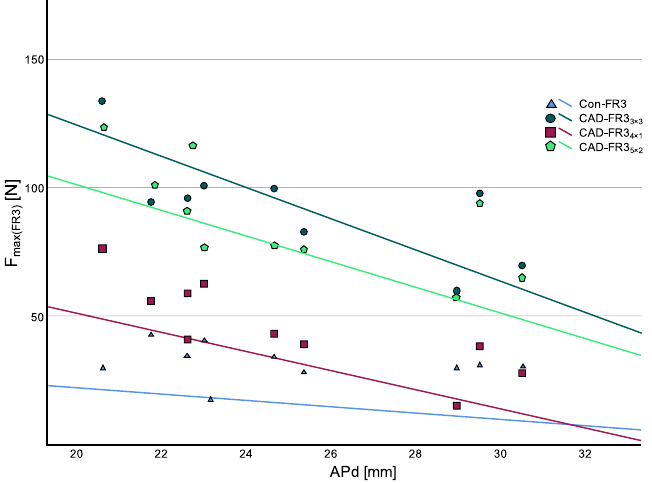
Figure 8. Load capacity (Fmax(FR3)) of function regulator 3 (FR3) designs in relation to anterior–posterior distance (APd). APd was measured from the loading point to the most anterior point of the respective FR3. All CAD/CAM FR3s (CAD-FR3s) showed a greater APd-dependent decrease of Fmax(FR3) than conventional FR3s (Con-FR3s). However, despite their greater APd-dependent decrease, all CAD-FR35 × 2 and CAD-FR33 × 3 still had higher Fmax(FR3) than the other groups.